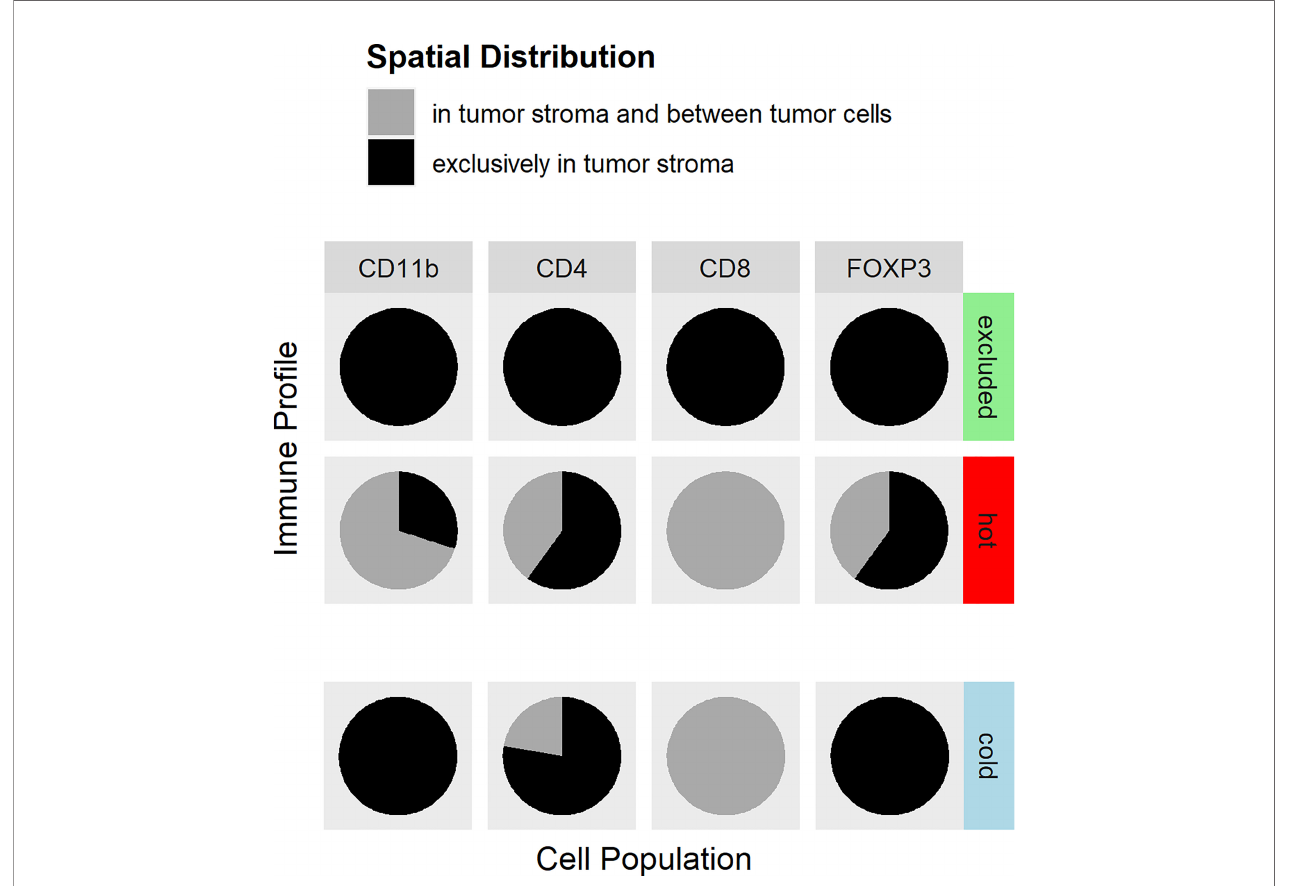
FIGURE 2 | Distribution of immune cell antigens in hot, cold, and excluded tumors. The distributions of CD4 lymphocytes, CD8 lymphocytes, CD11b-positive myeloid cells, and regulatory T cells (Tregs) within tumor tissues differed between hot, cold, and excluded tumors. In excluded tumors, all four cell types are found in the tumor stroma ( black ), but not in between cancer cells. In cold tumors, there were only very few immune cells at all (indicated by the slight offset ). The few CD8 T cells were found in the stroma and in between cancer cells ( gray ), CD4 T cells were, in most cases, in the stroma ( black ) and only in a few cases in between cancer cells and in the stroma ( gray ), while Tregs and myeloid cells were only in the stroma ( black ) in cold tumors. In hot tumors, CD8 T lymphocytes were found in the tumor stroma and in between cancer cells ( gray ). CD4 T lymphocytes and Tregs were located exclusively in the tumor stroma in most hot tumors ( black ), and in fewer cases, CD4 T lymphocytes were between cancer cells and in the stroma ( gray ). CD11b cells were in the stroma and in between cancer cells ( gray ) in most hot tumors, but in some hot tumors, they were only found in the stroma ( black ).